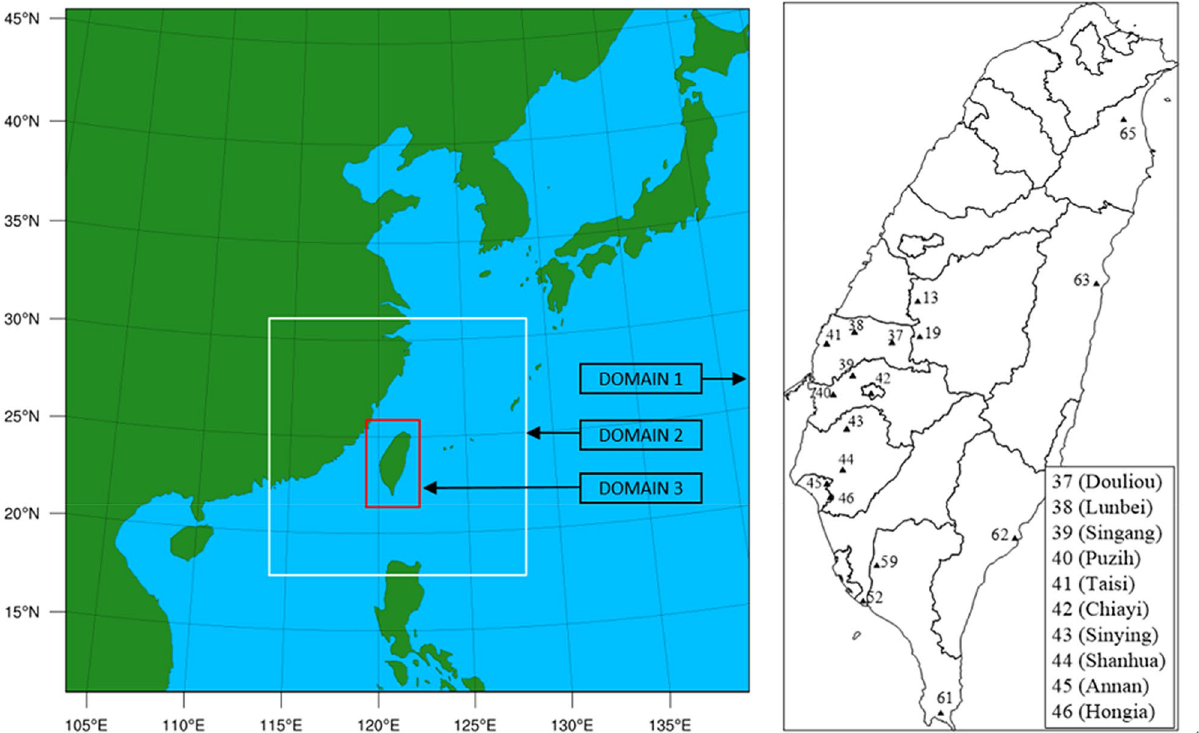
Figure 2. Configuration of the three-level nested domain used in this study and the monitoring stations in Domain 3 (the left map is produced with NCAR Command Language Version 6.6.2, and the right map is plotted with Surfer(R) Version 8.05, https ://www.golde nsoft ware.com/produ cts/surfe r).